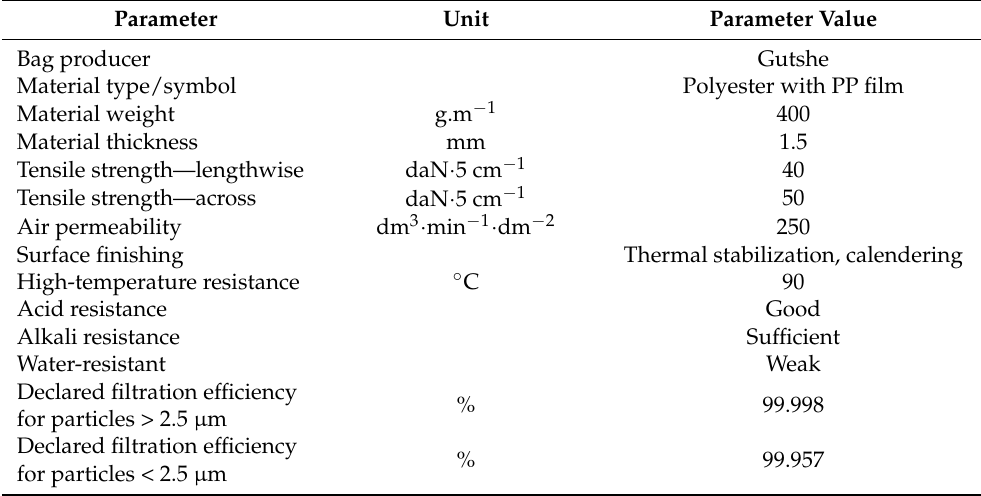
Table 2. Basic technical parameters of the filter bags used according to the